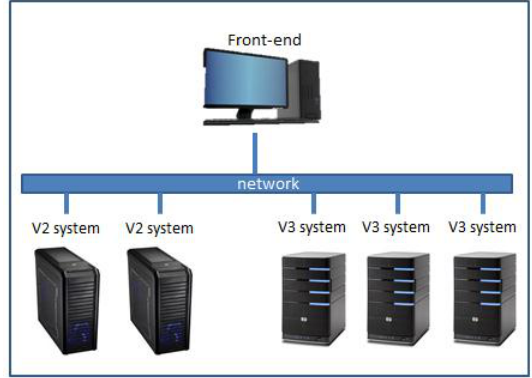
Figure 4 Example for the UltraMap v3 processing environment.